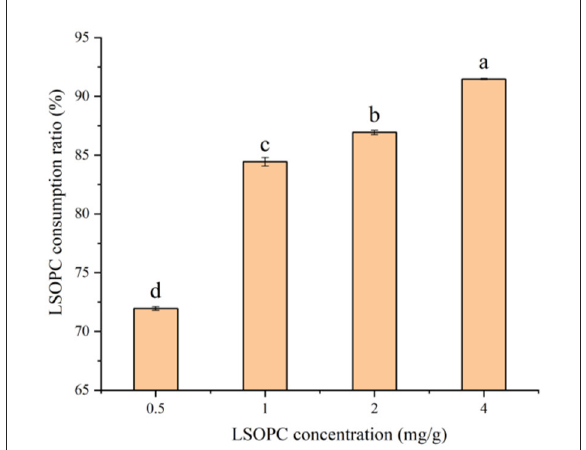
FIGURE3 Effect of different concentrations of LSOPC on its consumption ratio in biscuits. Significant differences ( p < 0.05) of data values were indicated by different letters.